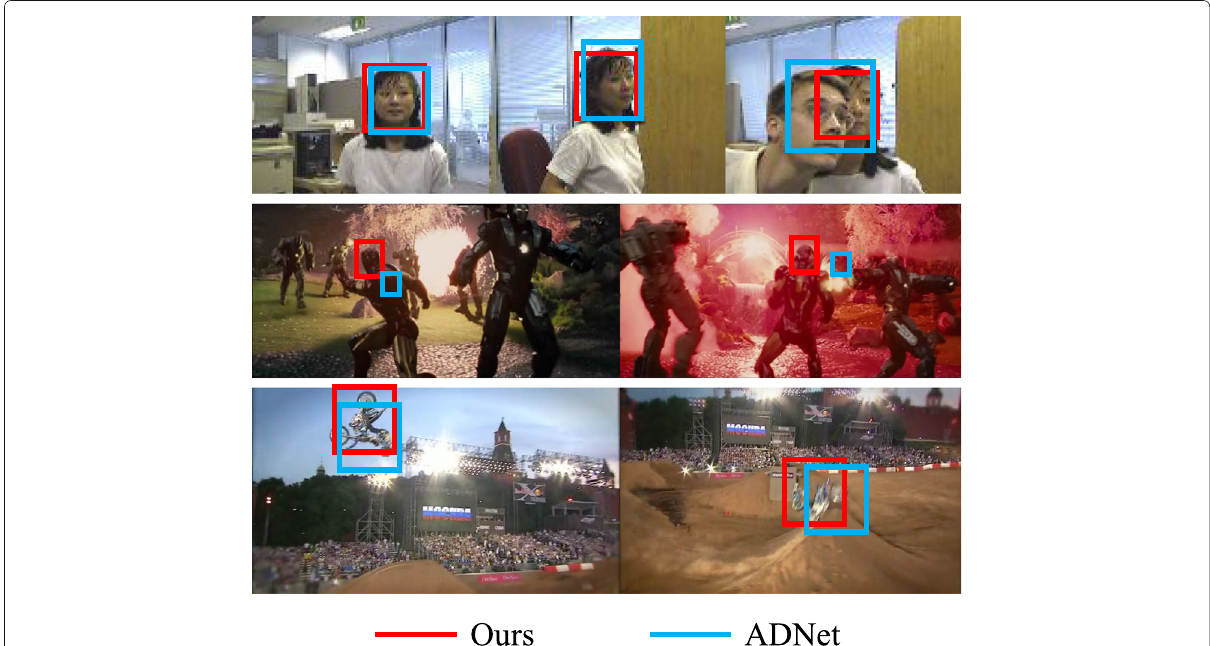
Fig. 2 Comparison of the proposed approach against state-of-the-art tracking methods ADNet on three example sequences challenged by large occlusion (top row), illumination variation (middle row), and fast motion (bottom row). Our approach performs more robustly than the ADNet tracking